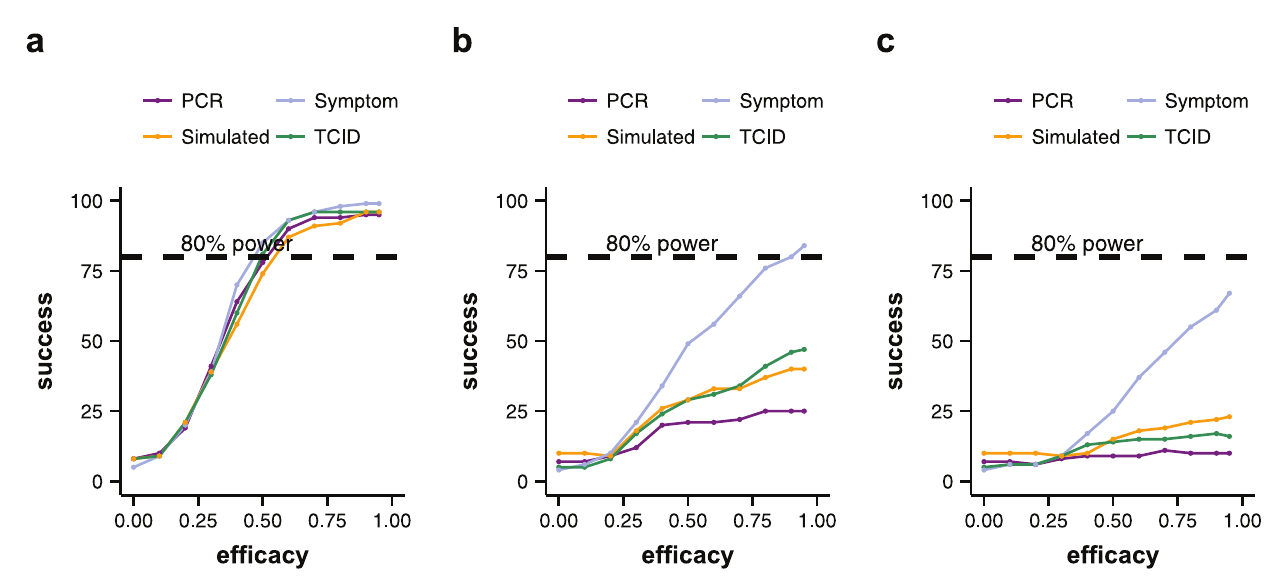
Fig 5. Experiment 6: Day of Treatment. Treatment acts on all model parameters. Plots show the number of successful trials out of 100 runs (y-axis) over the assumed mean efficacy of treatment (x-axis). The probability of success corresponds to the power of the trial. The parameters determining the course of natural infection were drawn from the same random number distributions for each patient as explained in the main text. The efficacy for each patient (response) was fixed to the same value for each patient in each run. The later treatment is given, the lower the power of the trial. a: treatment on day 1; b: treatment on day 2; c: treatment on day 3. Coloured lines show power of the trial depending on efficacy for different endpoint measurements (PCR: viral load AUC measured with qPCR; Symptom: temperature AUC; TCID: viral load AUC measured with TCID 50 ; True: viral load AUC of the simulated viral load AUC).